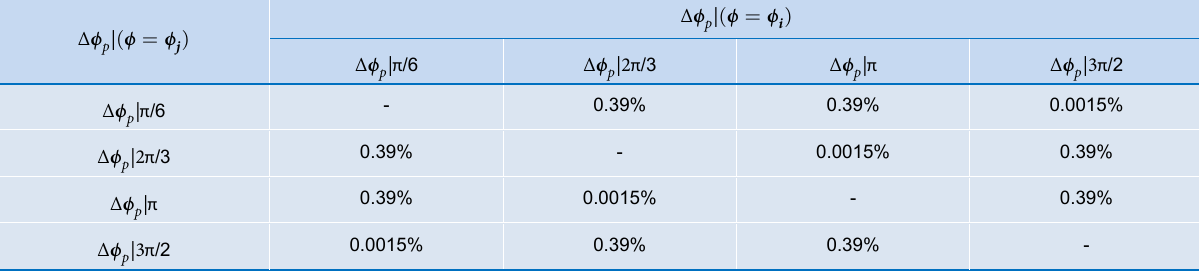
S ϕ = ϕj Table 4 | Probability that any two sets and have the same symbol under encoding rule (π/6, 2π/3, π,